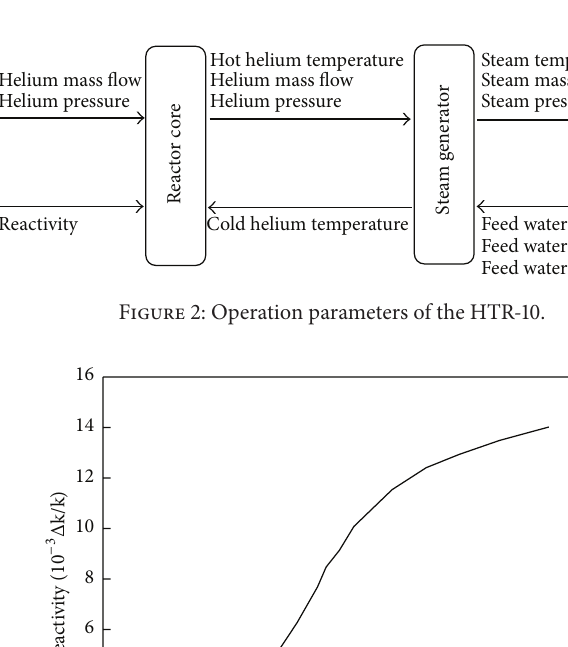
Figure 1: Primary system of the HTR-10.